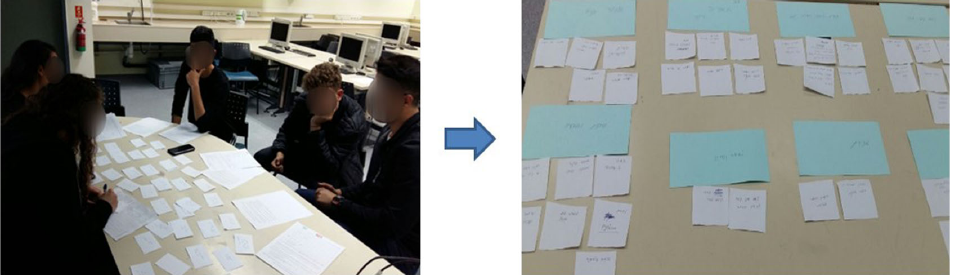
FIG. 1. Step 3 of the GAIQ: students creating a unified list of inquiry tasks they encountered during the introductory stage (left) and categorizing them (right). Students used labeled tabs to facilitate the sorting process.